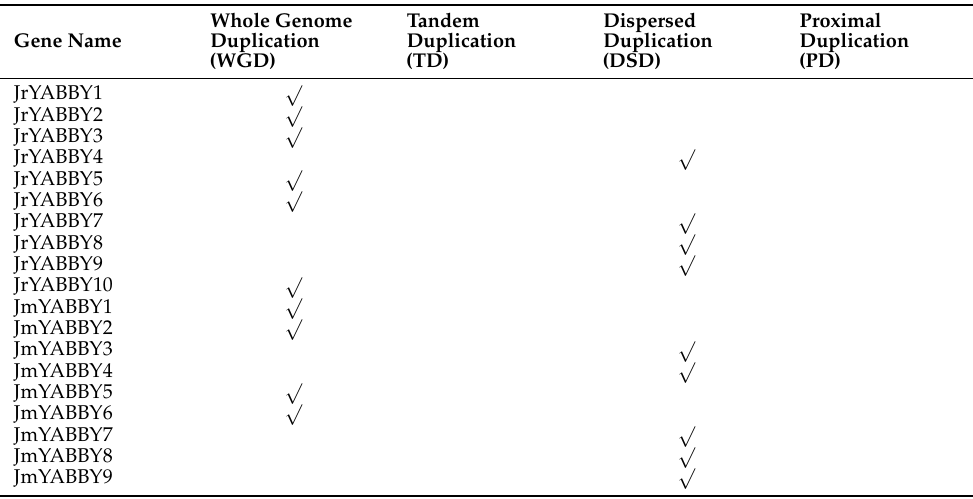
Figure 2. Gene structures and protein domains of YABBY gene members. ( a ) Maximum likelihood phylogenetic tree of YABBY in two Juglans species. ( b ) Protein domains of YABBYS in two Juglans species. Various domains are represented by different colored boxes. ( c ) Gene structures of YABBYS in two Juglans species. Green boxes indicate exons, and gray lines indicate introns. ( d ) Multiple sequence alignment of the YABBY family genes from two Juglans species. Table 2. Four duplicated types of YABBY genes in J. regia and J. mandshurica